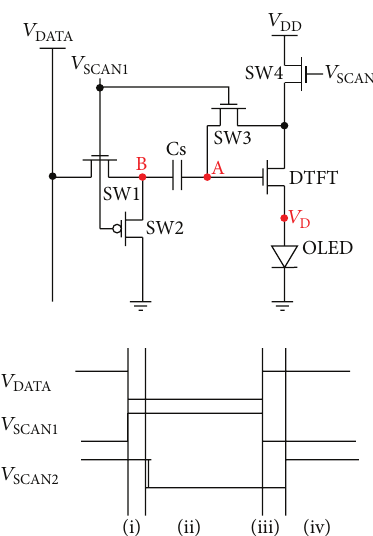
Figure 2: Proposed pixel design and timing scheme of the signal